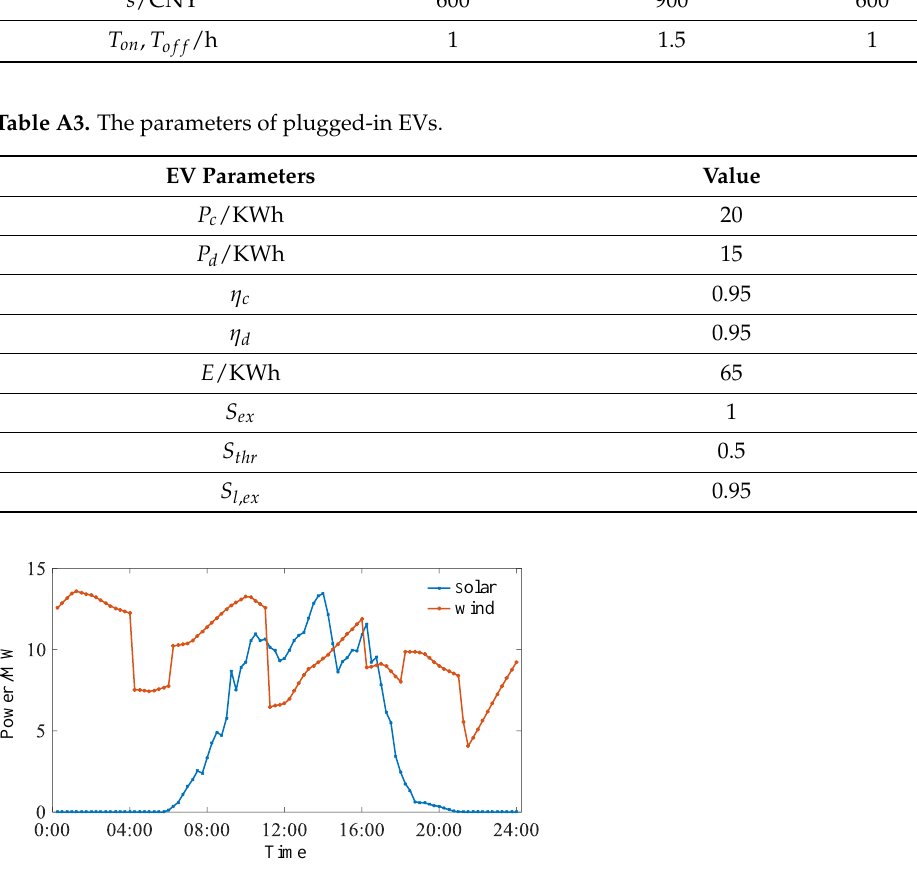
Figure A1. Solar power and wind power.